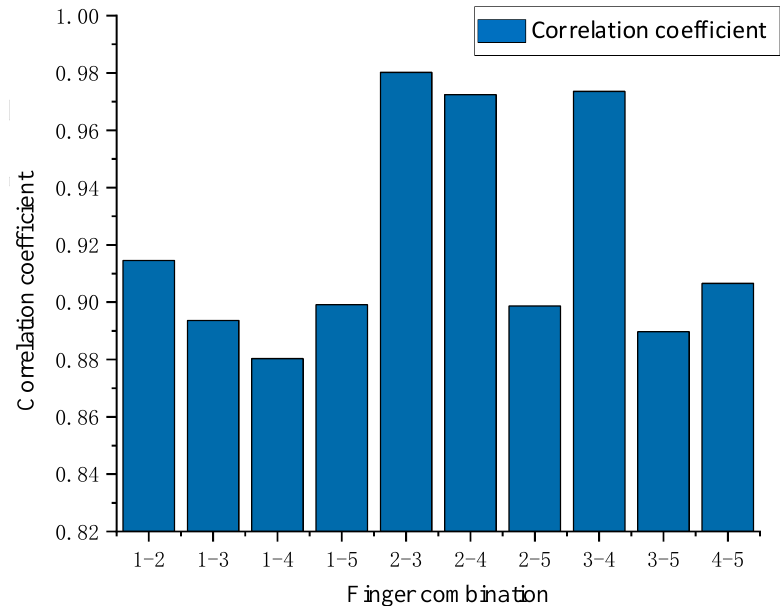
Figure 6. Correlation coefficient of five-finger curvature.